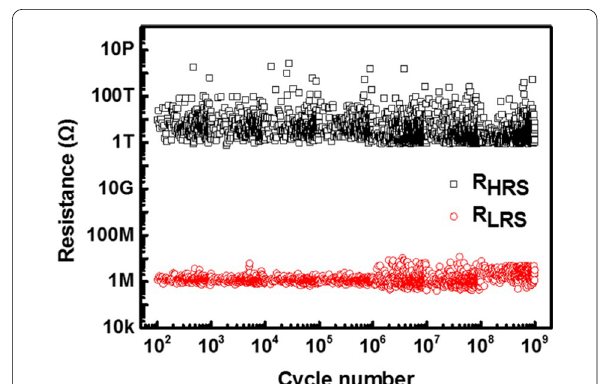
Fig. 6 AC endurance characteristic of the Ag-Ga 2 Te 3 selector device up to 10 9 cycles (0.5 V and 3 V reading voltages for R HRS and R LRS ,